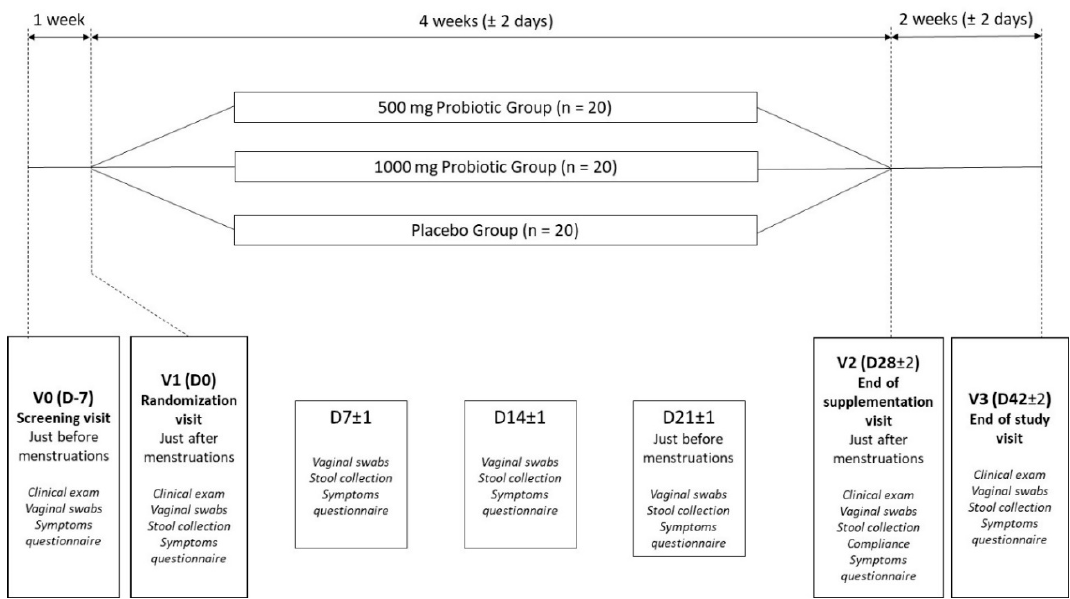
Figure 1. Experimental design of the clinical study (this diagram presents the study timeline (days, D) and the visits (V). For example, V1 corresponds to the randomization visit planned at D0 which is the first day of the supplementation phase).